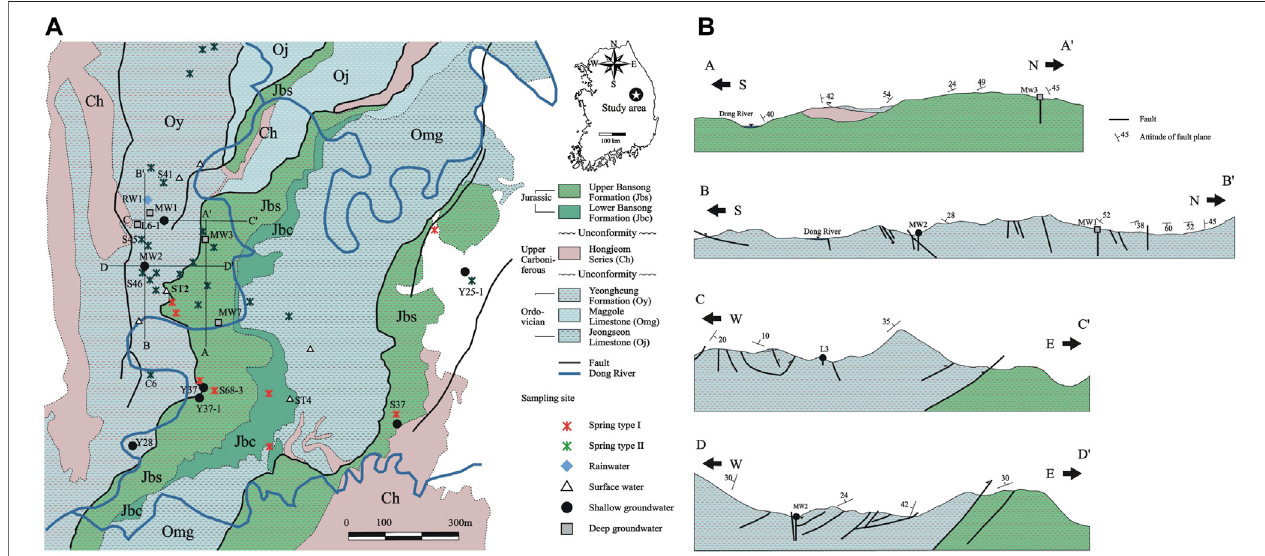
FIGURE1| GeologicmapofthestudyareainSouth Korea: (A) plan view; (B) cross sectionsalongA-A ’ ,B-B ’ ,C-C ’ andD-D ’ in (A) .In (A) ,thewhiteareaindicates Kosong limestone (Ogl) of unknown age. Sampling locations are also shown, while the names are labeled only for the samples mentioned in the text. All sample names are shown on the land use map in Supplementary Figure S2 . Springs were divided into Type Ⅰ and Ⅱ when sampled based on the manner by which the discharge occurred (i.e., low and high, respectively).